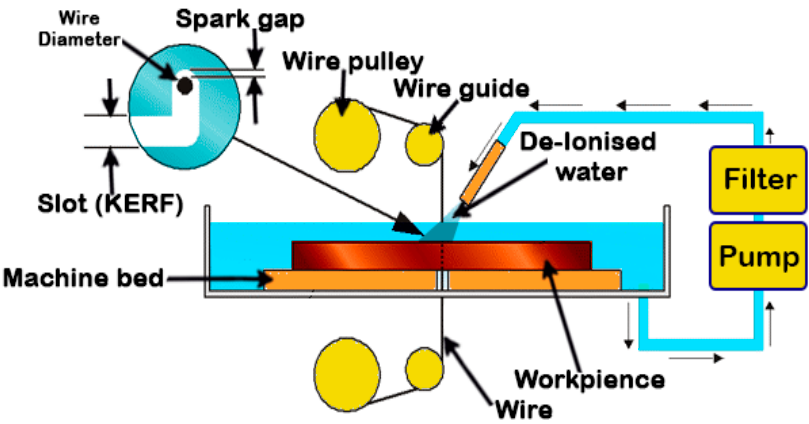
Figure 3. Schematic diagram of wire EDM.